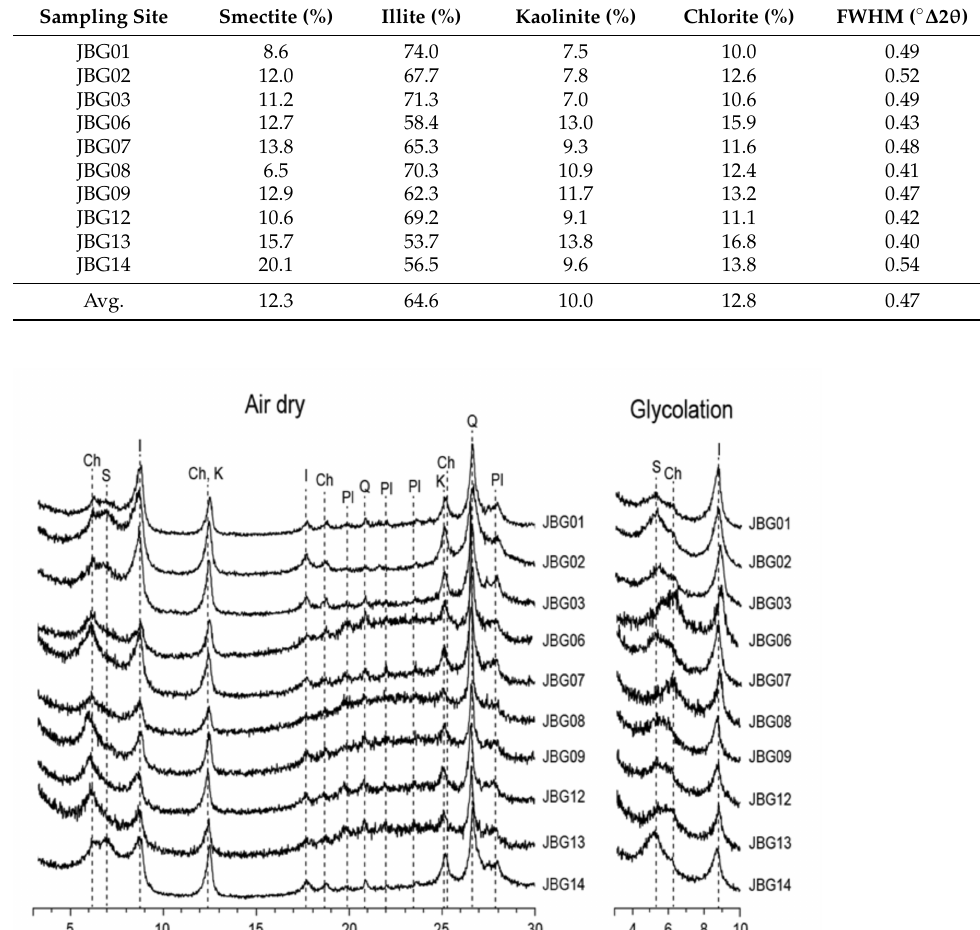
Table 3. Relative abundance of clay minerals and full width at half maximum 10 Å peak of il- lite/muscovite (FWHM-10 Å) of surface sediments collected from Terra Nova Bay, Antarctica.